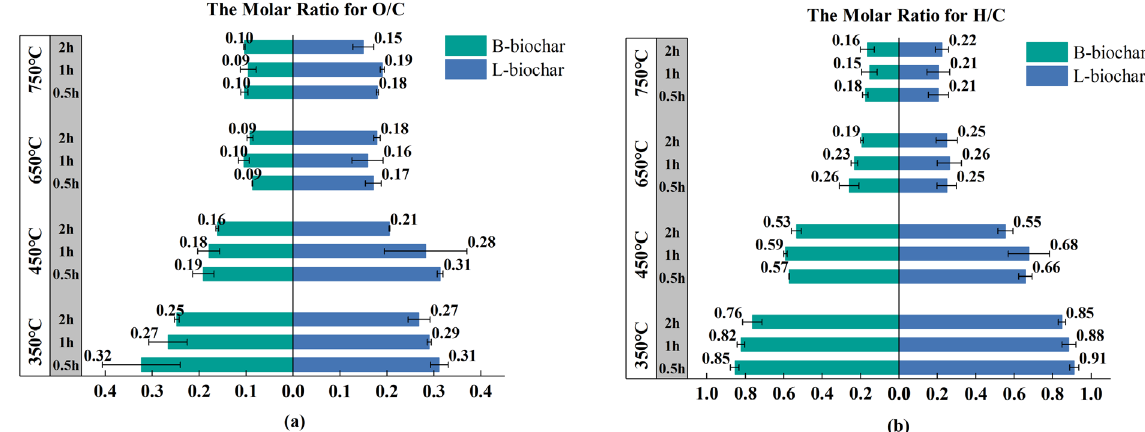
Figure 2. Illustrates how the molar ratios for O/C and H/C of all manufactured biochar evolved with the pyrolysis temperature and time: ( a ) indicates comparison of the O/C molar ratio between B-biochar and L-biochar; while ( b ) indicates comparison of the H/C ratio between B-biochar and L-biochar. Table 4. Elemental composition on biochar